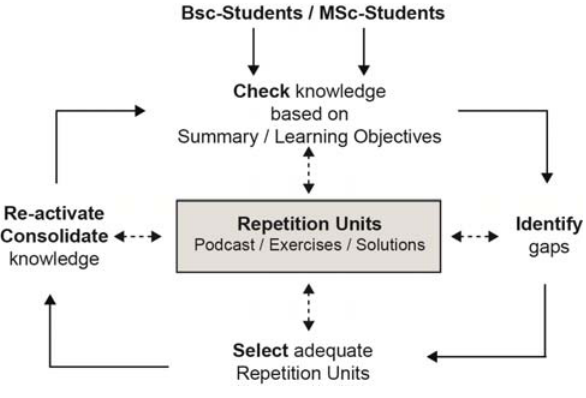
Figure 3. “Study cycle” of the Repetition